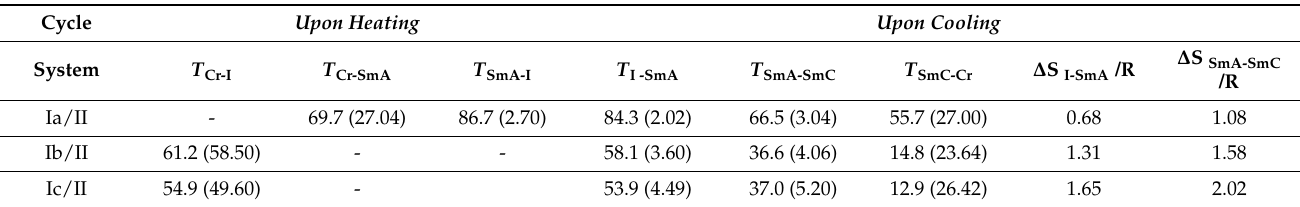
Table 1. Phase transition temperatures ( T , ◦ C), enthalpy of transitions ( ∆ H , kJ/mol), and normalized transition entropy ( ∆ S ) of supramolecular complexes Ix/II .